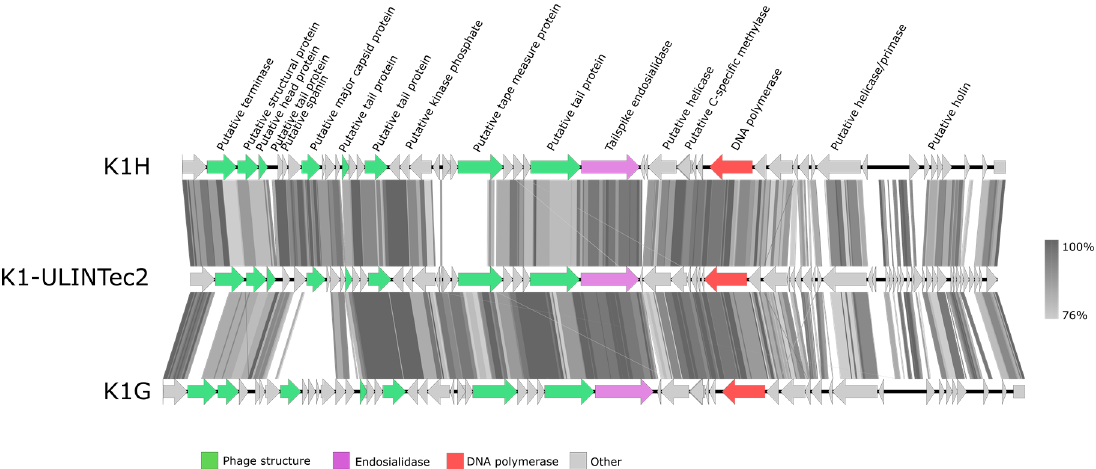
Figure 5. Comparative genomics of phages vB_EcoS_K1-ULINTec2 (K1-ULINTec2), K1H and K1G.